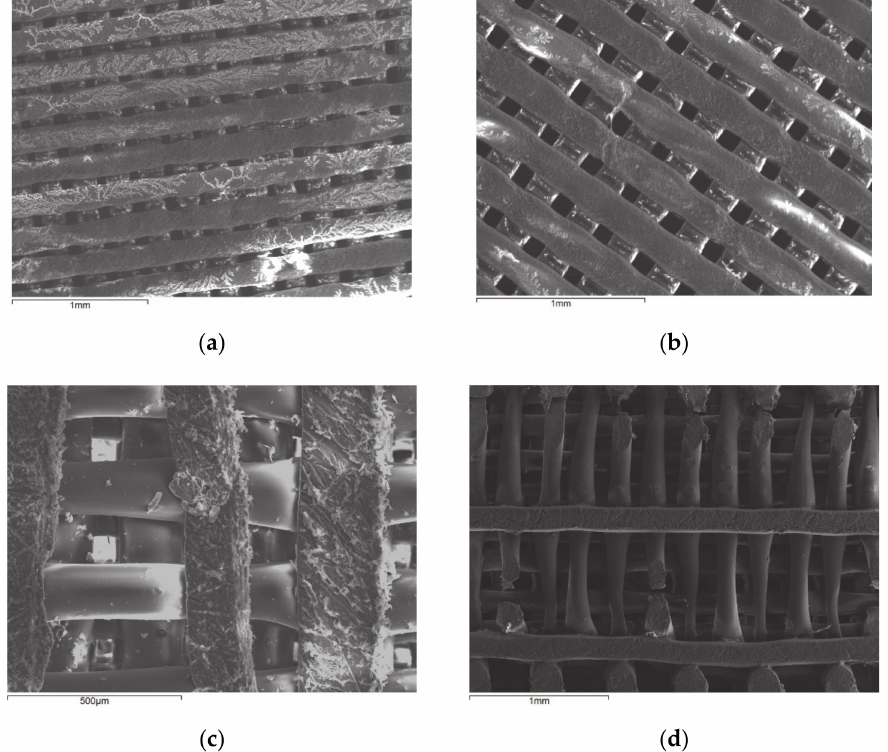
Figure 5. Micrographs of scaffolds with pore side length:( a ) 60 µ m, ( b ) 100 µ m, ( c ) 100 µ m, and ( d ) 100 µ m after immersion in simulated body fluid (SBF) for 8 h.